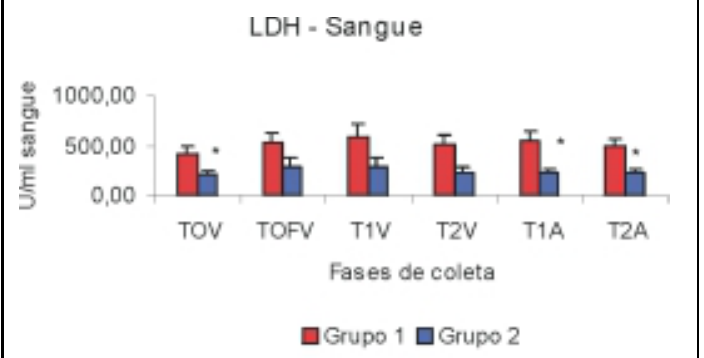
FIGURA 5 - Concentração de LDH no